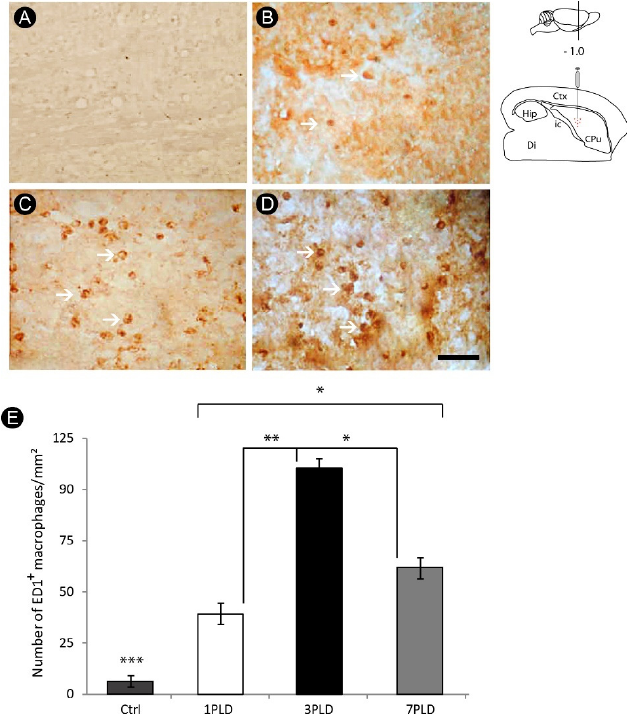
Figure 4. Progressive macrophage/microglia activation in the internal capsule following endothelin-1 (ET-1) striatal injection. The inflammatory response is minimal in the control group ( A ). At 1PLD it is possible to notice a small number of ED1 + cells ( B ), followed by a significant increase at 3PLD ( C ), with a decrease at 7PLD ( D ), as confirmed by quantitative analysis ( E ) (* p < 0.05; ** p < 0.01; *** p < 0.001, ANOVA, Tukey post hoc test). Values expressed as mean ± SEM. Arrows in B, C and D point to ED1 + cells. Drawings at the left side of the figure show the anatomical localization of the ET-1 injection in the striatum. Ctx: cortex; CPu: caudate putamen (striatum); Di: diencephalon; Hip: hippocampus; ic: internal capsule. Scale bar: 50 µ m.